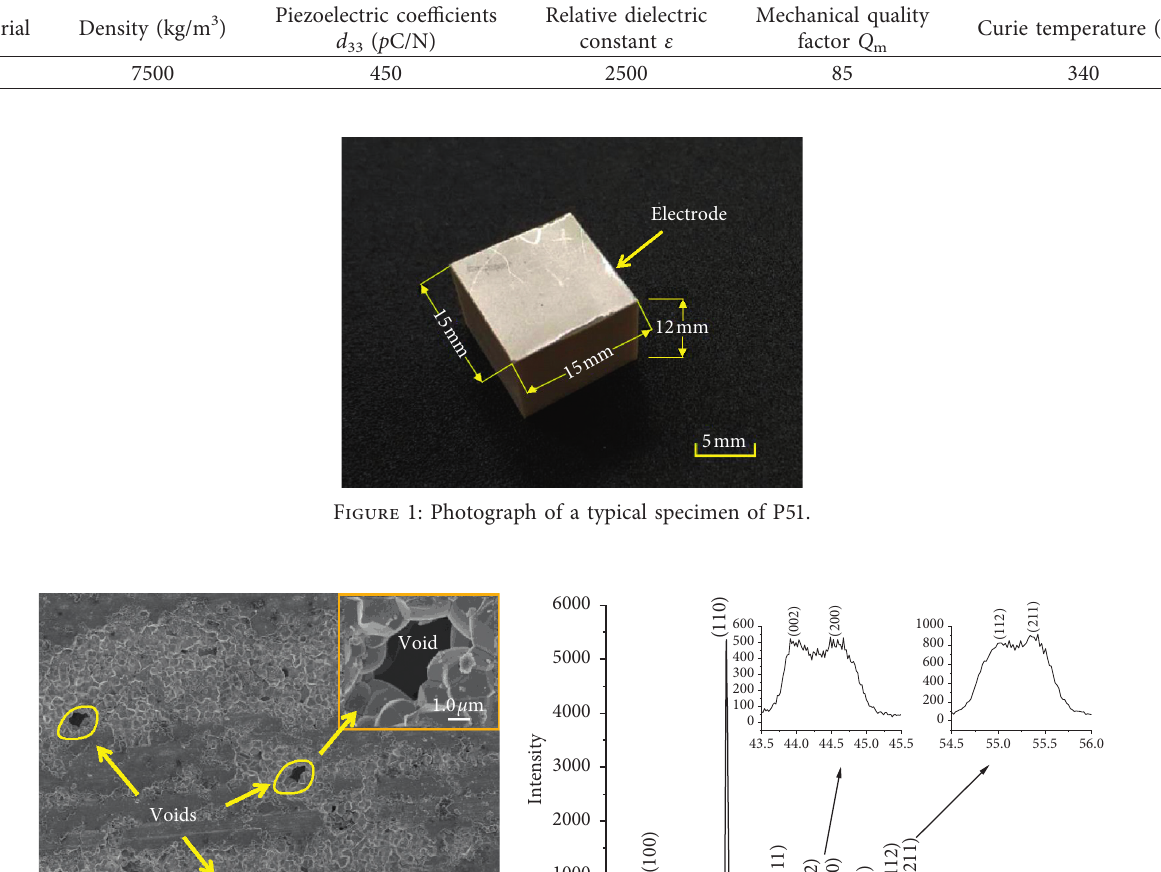
Table 1: The physical and electromechanical properties of P51.